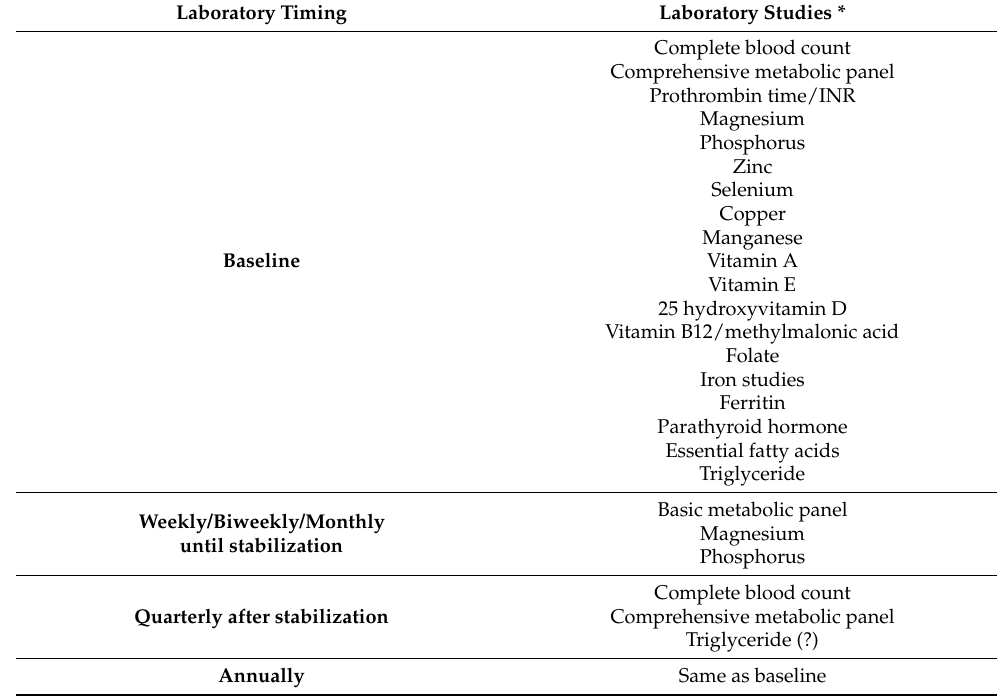
Table 4. Recommended laboratory monitoring for